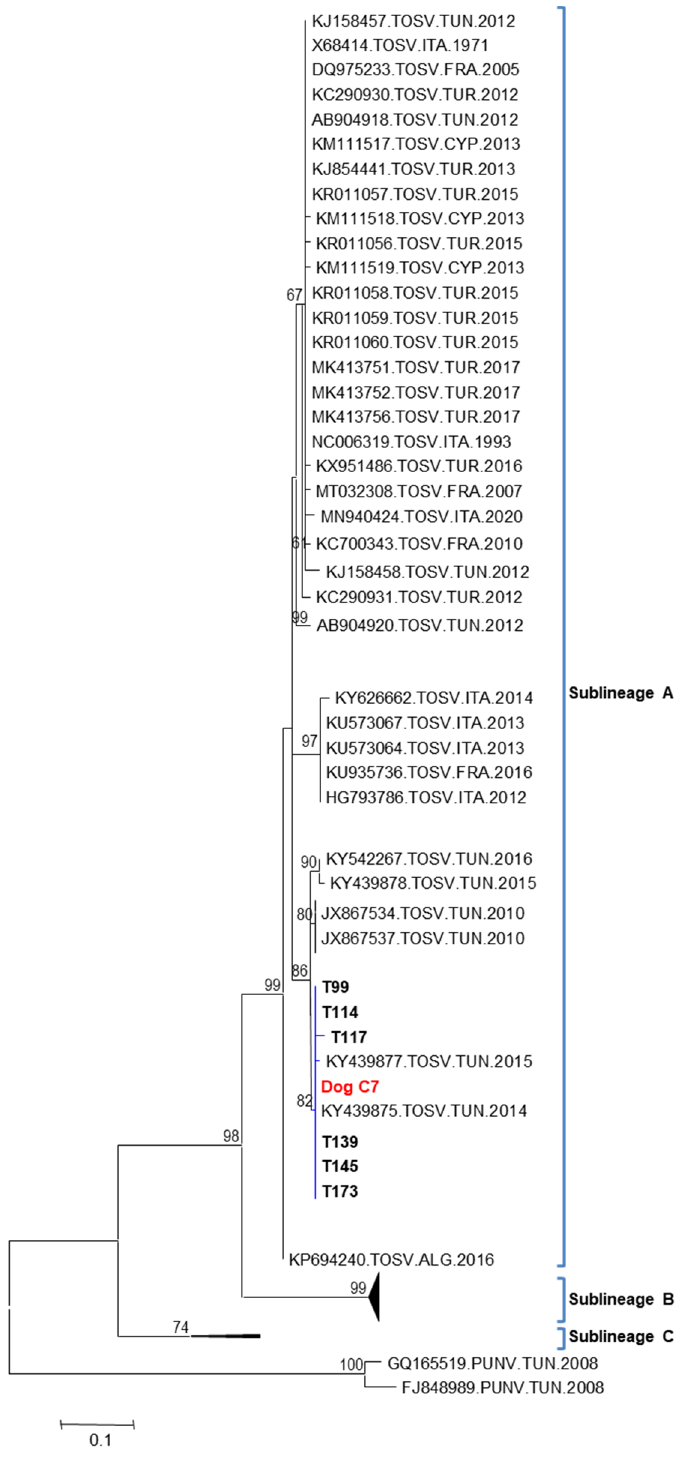
Figure 3. Phylogenetic tree based on the 201 bp of the L segment. Phylogenetic analysis was performed using the maximum likelihood analysis method and the Tamura 3 model. The tree topology was supported by 1000 bootstrap replicates. Punique virus (PUNV) sequences were used as an outgroup.